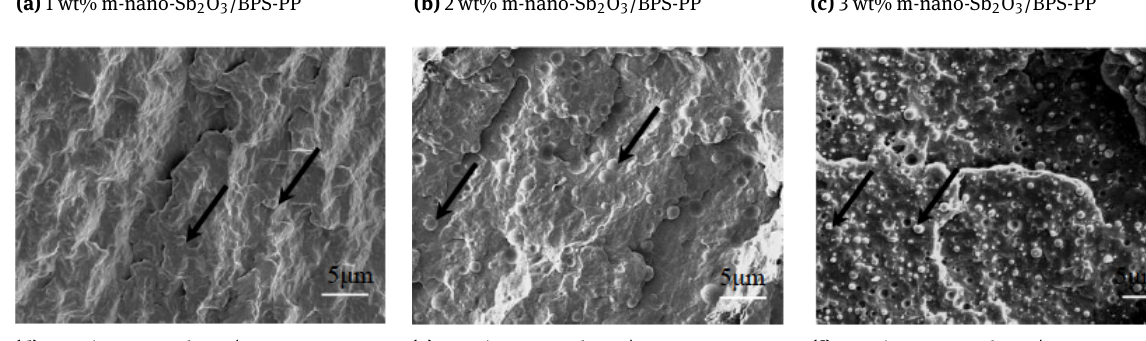
PP matrix to form compact microstructure of the